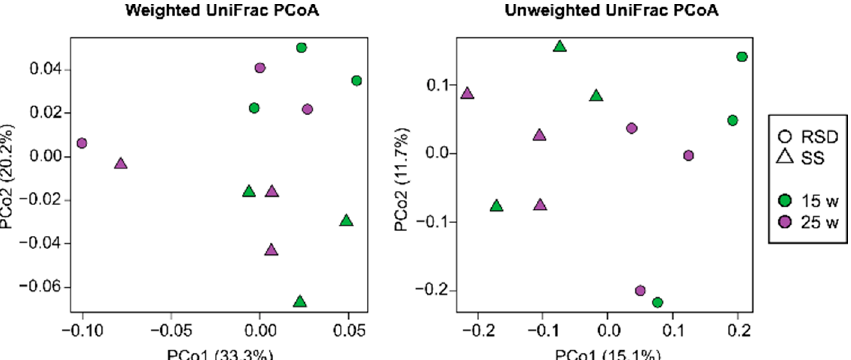
Figure 7. Weighted and Unweighted UniFrac-based principal coordinate analysis (PCoA) of the soil bacterial communities during the tomato cultivation period after ( ○ ) reductive soil disinfestation (RSD) and ( △ ) soil solarization (SS). Green and purple denote 15 and 25 w: treatment period for 15 and 25 weeks.